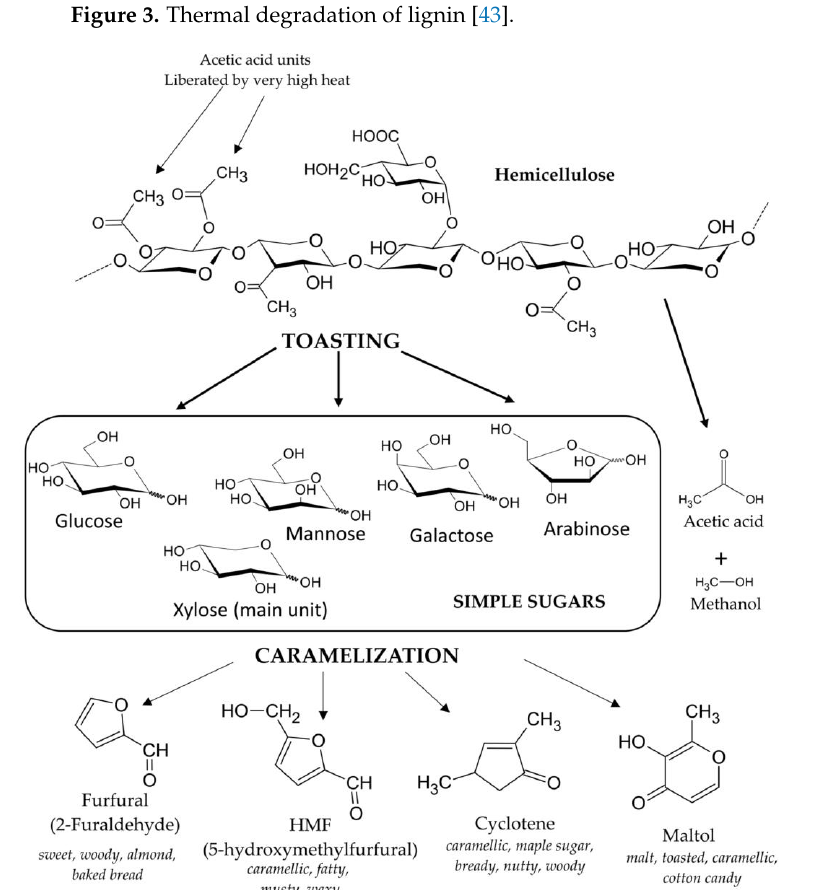
Figure 4. The structure of a hemicellulose molecule and the products liberated during toasting and caramelization processes [43].